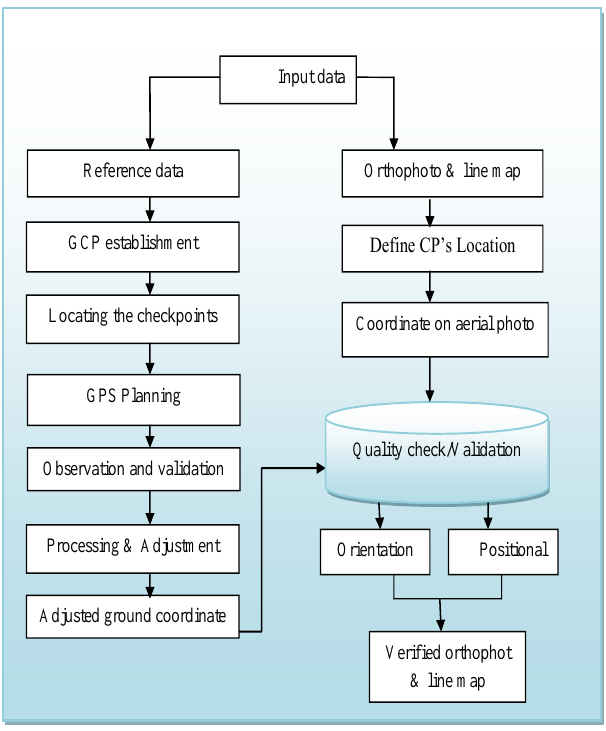
Figure 1. Positional and orientation assessment of digital orthophoto and line map schematic